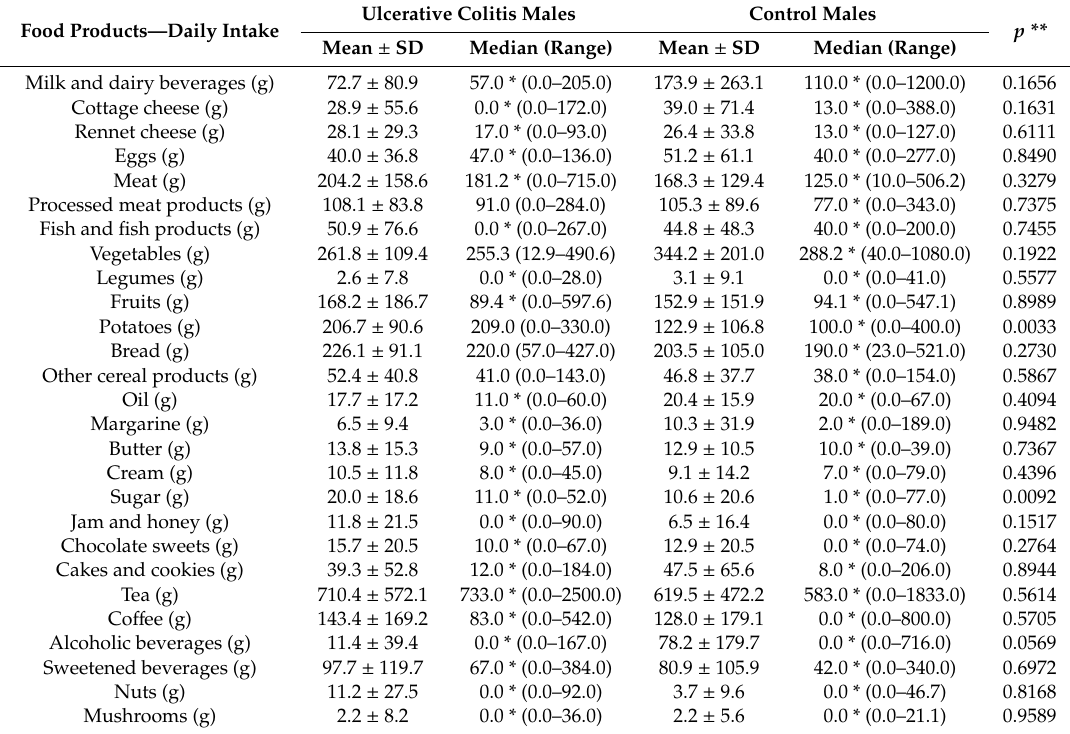
Table 7. The food products intake in ulcerative colitis males and control males. Food Products—Daily Intake